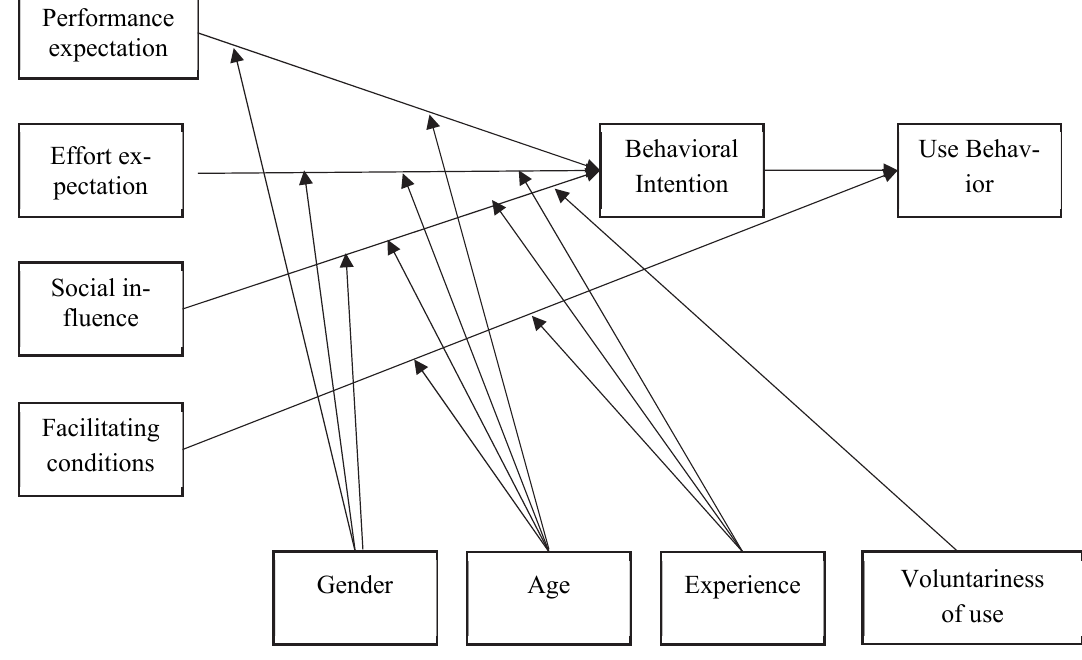
Fig. 1. Theoretical model of technology adoption and use (Venkatesh et al.,